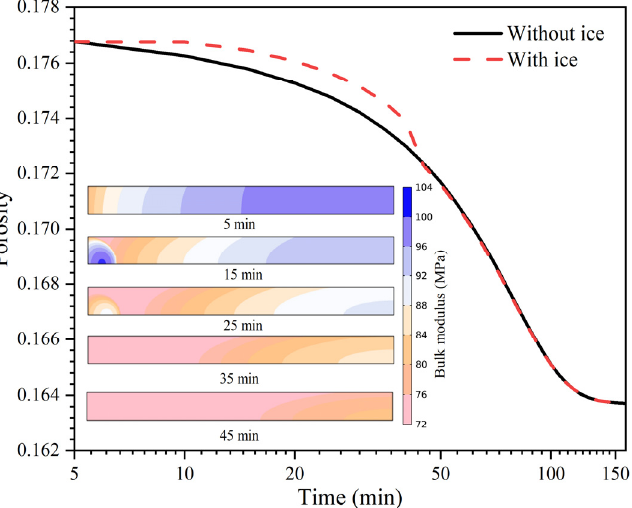
Figure 8. The variation in porosity with or without ice and the distribution of bulk modulus with ice at the specimen.